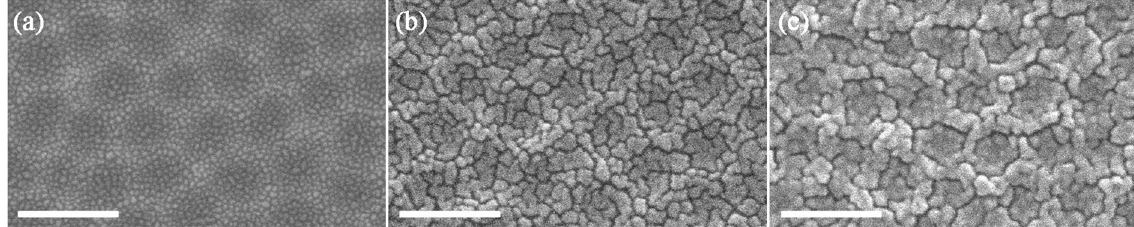
Figure 3. SEM images of Au-coated Al nanobowl arrays ( V AAO = 40 V) with t Au value of ( a ) 2.5 nm, ( b ) 7.5 nm and ( c ) 12.5 nm, respectively. The scale bars in SEM images are 200 nm.